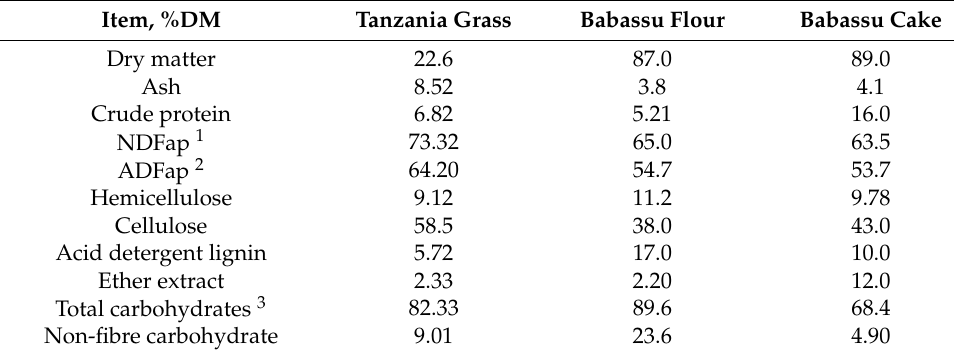
Table 1. Chemical composition of babassu by-products. Item,